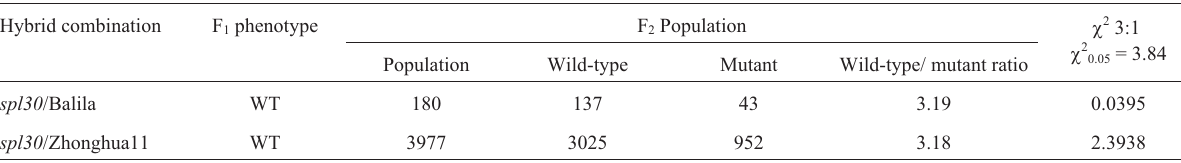
Table 2 - Segregation of wild-type and mutant plants in F 2 populations of spl30 . Hybrid